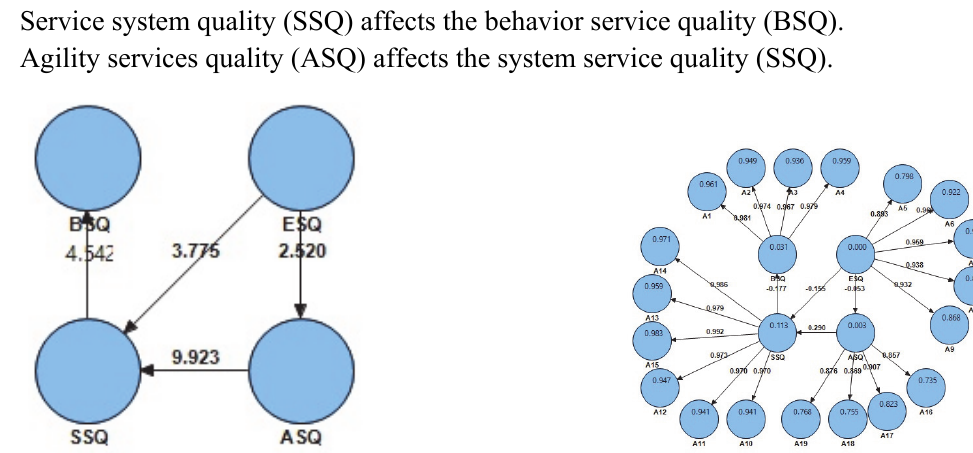
Fig. 3. t-statistics of the structural model Fig. 4. The coefficients of the components related to each variable in the structural equations